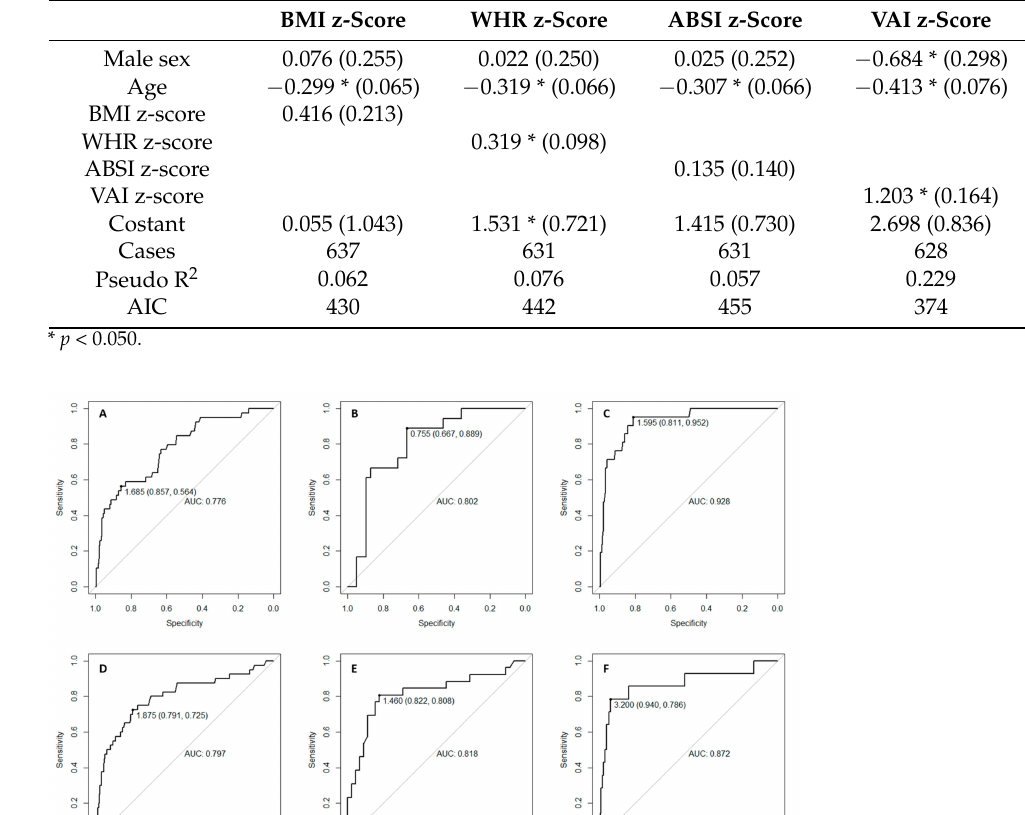
Table 4. Logistic regression coefficients (standard errors) of adiposity indices and VAI with the presence of MetS.